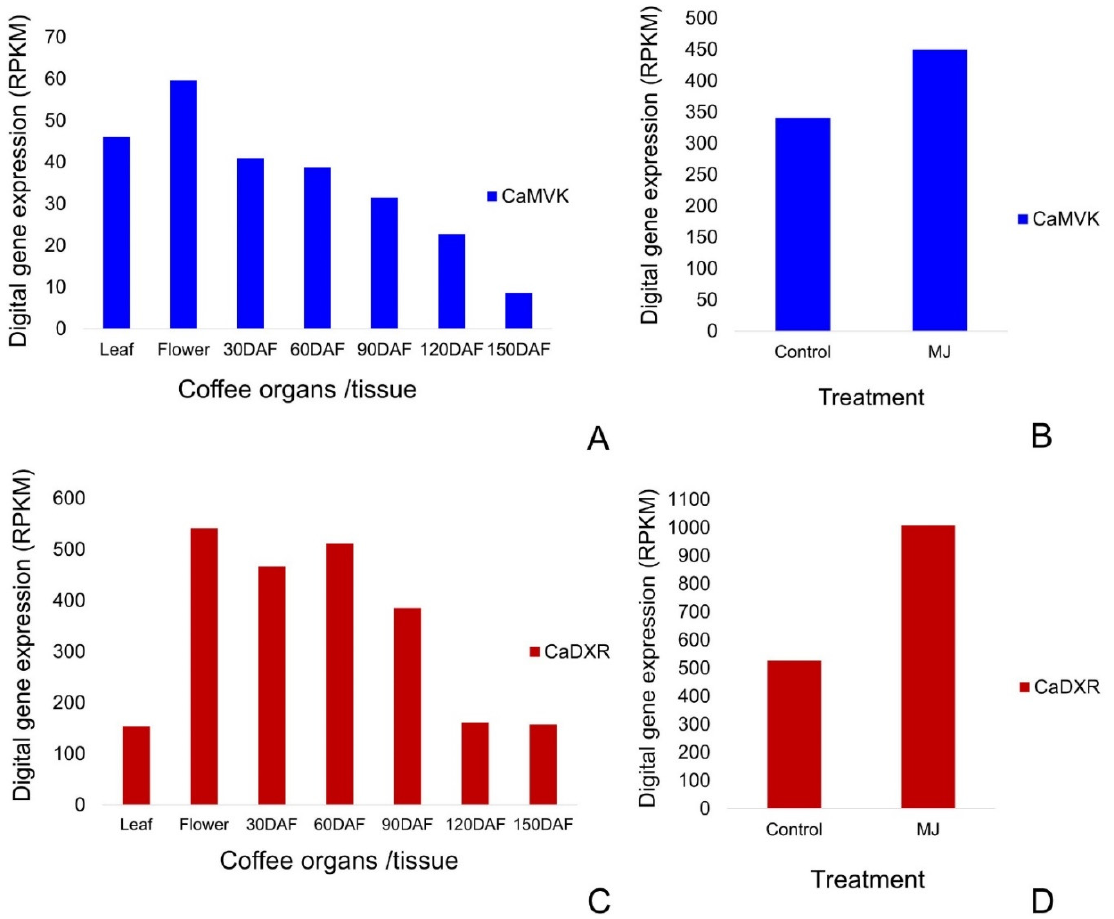
Figure 7. Digital expression profiles of CaMVK (blue) and CaDXR (red) genes in leaves, flowers and fruits (30 to 150 days after flowering, DAF) in C. arabica ( A , C ) and under the application of 2mM methyl jasmonate (MJ) ( B , D ). Transcript levels are expressed in reads per kilo base per million mapped reads (RPKM) values.